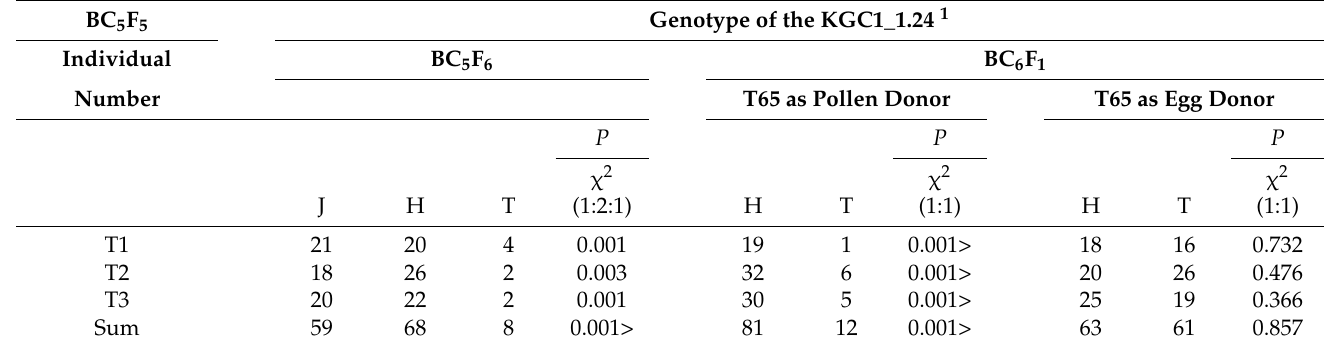
Table 6. Segregation of progeny of BC 5 F 5 heterozygous for KGC1_1.24 genotype.